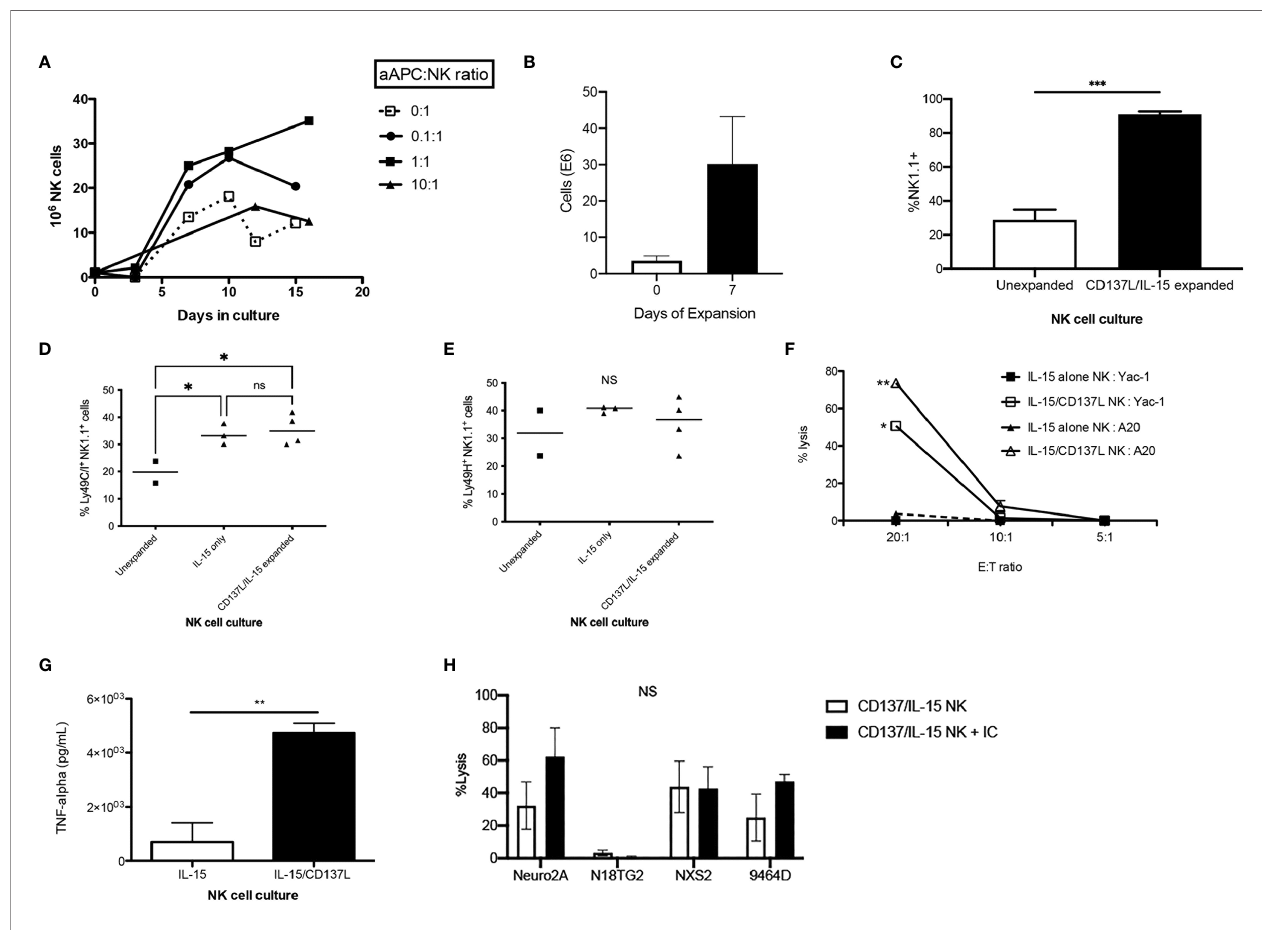
FIGURE 3 | In vitro characterization of ex vivo CD137L/IL-15/IL-15R a expanded NK cells. Donor B6 NK cells were expanded in vitro with IL-15/IL-15R a alone (0:1) or with IL-15/IL-15R a plus an aAPC expressing 4-1BBL (CD137L) at a logarithmically increasing dose of aAPC : NK cell ratios (0.1:1-10:1). (A) Cell counts were enumerated twice per week. Results pooled from 4 separate cultures. (B) After 1 week, NK cells expanded without aAPC or IL-15/IL-15R a (unexpanded) were compared to NK cells expanded with the aAPC at a 1:1 ratio (CD137L/IL-15/IL-15R a expanded) for (C) NK1.1 purity, (D) inhibitory Ly49C/I expression and (E) activating Ly49H expression. Results pooled from 2 separate experiments, 2-7 mice/group. (F) Balb/c NK cells (H-2 d ) expanded with IL-15/IL-15R a or with IL-15/IL- 15R a and CD137L aAPCs at a 1:1 NK:aAPC ratio for 1 week were compared for their ability to lyse syngeneic A20 (H-2 d ) or allogeneic Yac-1 (H-2 a ) lymphoma cells at various E:T ratios using a 4 hour LDH release cytotoxicity assay, performed in triplicate. (G) NK cells expanded without aAPC (IL-15) were compared to NK cells expanded with the aAPC at a 1:1 ratio (IL-15/CD137L) and examined for TNF- a production by ELISA, performed in triplicate. (H) B6 (H-2 b ) NK cells expanded with IL-15/IL-15R a and CD137L aAPCs at a 1:1 NK:aAPC ratio for 1 week were tested for their ability to lyse murine neuroblastoma cell lines Neuro2a, N18TG2, NXS2, and 9464D (H-2 a ) using a 4 hour calcein-AM release cytotoxicity assay, performed in triplicate. *p < 0.05, **p < 0.01, ***p < 0.001, NS, not signi fi